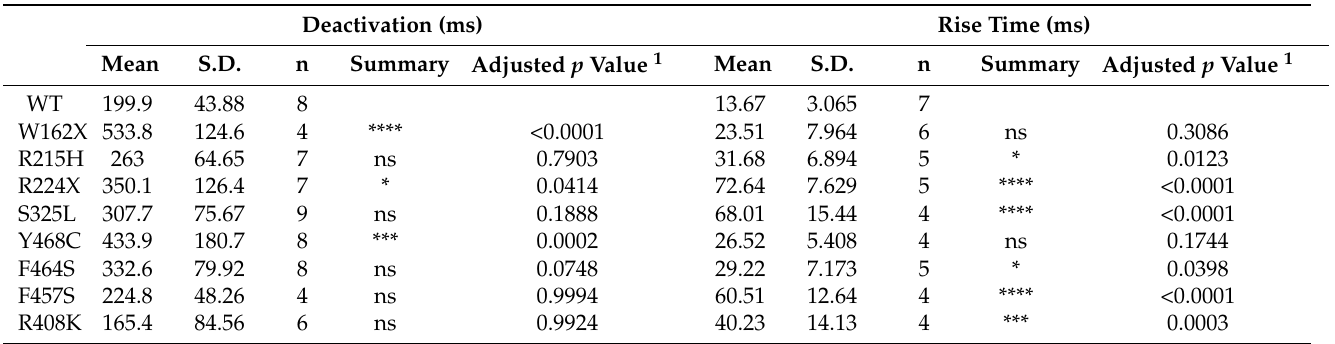
Table 2. Effects of GABRG2 variants on α 1 β 3 γ 2 receptor macroscopic